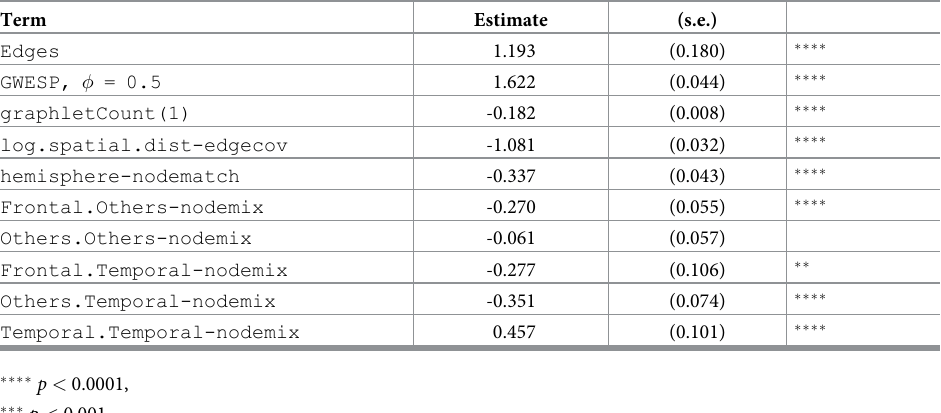
Table 5. Model parameter estimates and standard errors for pooled-ERGM analysis of brain functional connectiv- ity networks. (For nodemix effects, Frontal-Frontal is the reference category).